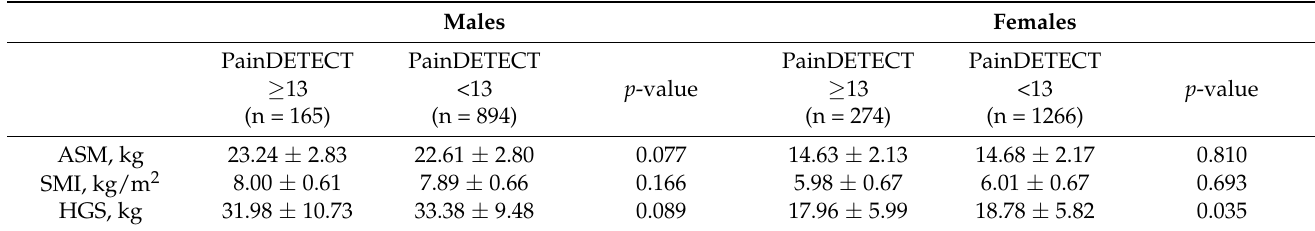
Table 2. Sex-specific comparison of sarcopenia-related data between patients who reported a painDE- TECT score ≥ 13 (possible neuropathic-like pain symptoms) and those with a painDETECT score < 13 in patients with chronic musculoskeletal pain.